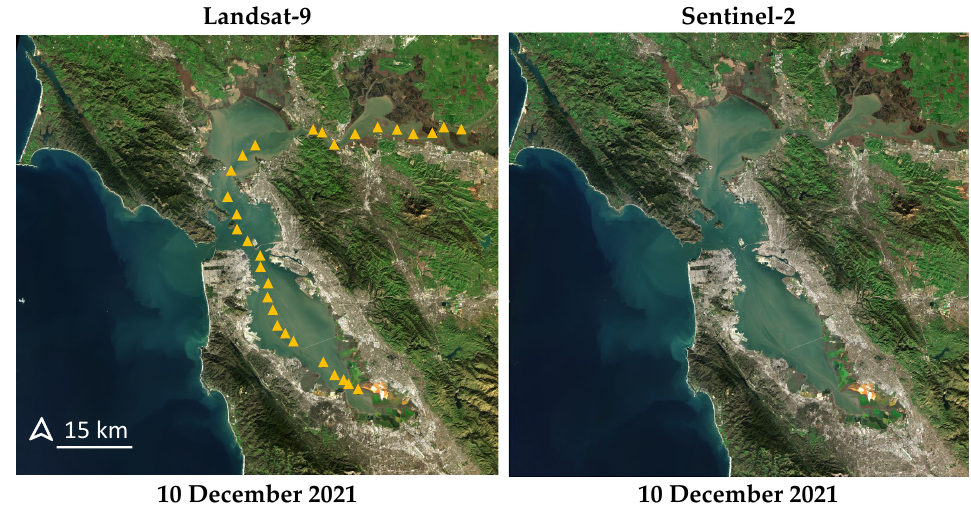
Figure 3. True color composite Landsat-9 and near-simultaneous Sentinel-2 images over San Francisco Bay. The locations of in situ stations are shown on Landsat-9 images by yellow symbols. Table 1 reports the morphological characteristics and trophic status of case studies, quality matchups are provided for each water body during the studied period. Table 1. Site descriptions, image acquisition dates, and the number of in situ samples for each case study.